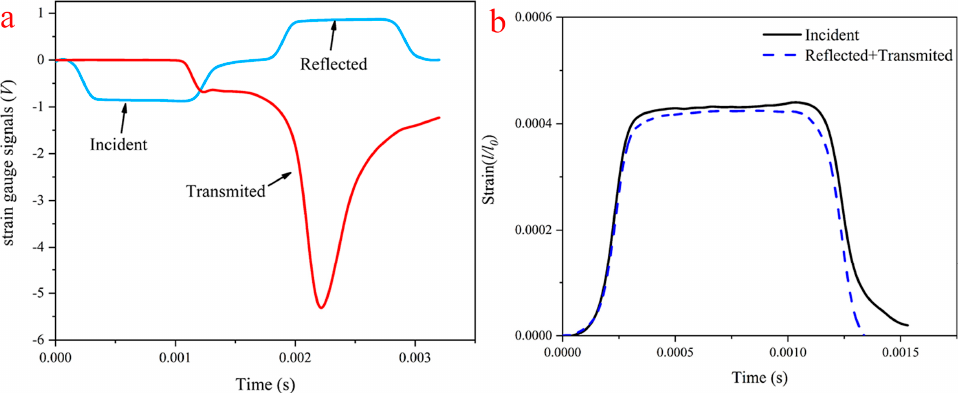
Figure 5. A representative set of ( a ) strain signals from incident and transmitter bars and ( b ) the stress equilibrium obtained in an H160 PVC foam specimen at a strain rate of 864 s − 1 .